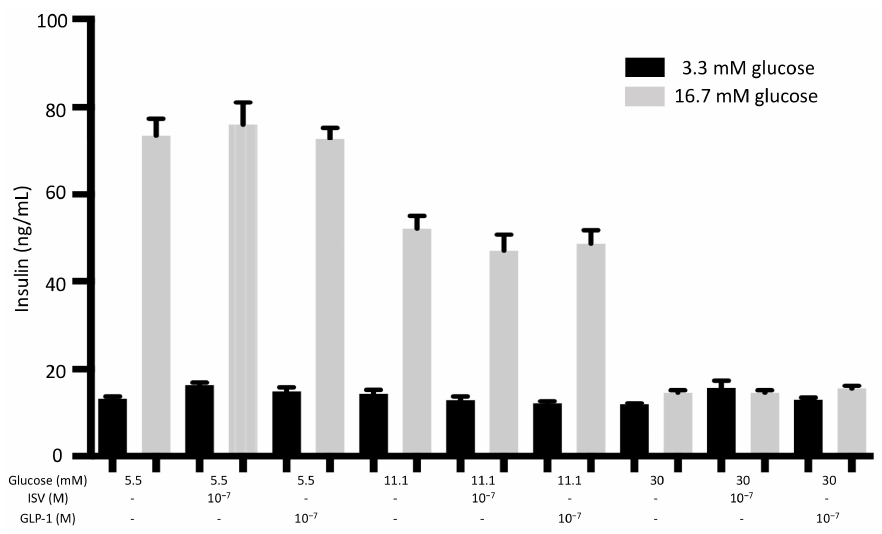
Figure 5. Effects of 10 − 7 M ISV and 10 − 7 M GLP-1 on insulin secretion from glucose-treated INS-1E cells. After 72 h of incubation with or without 10 − 7 M ISV and 10 − 7 M GLP-1, in the medium containing 5.5 mM, 11.1 mM, or 30 mM glucose, cells were stimulated with low (3.3 mM) and high (16.7 mM) glucose for 1 h, and subsequently insulin secretion was measured. Data are presented as the mean ± SEM of 18 samples per group from three independent experiments.